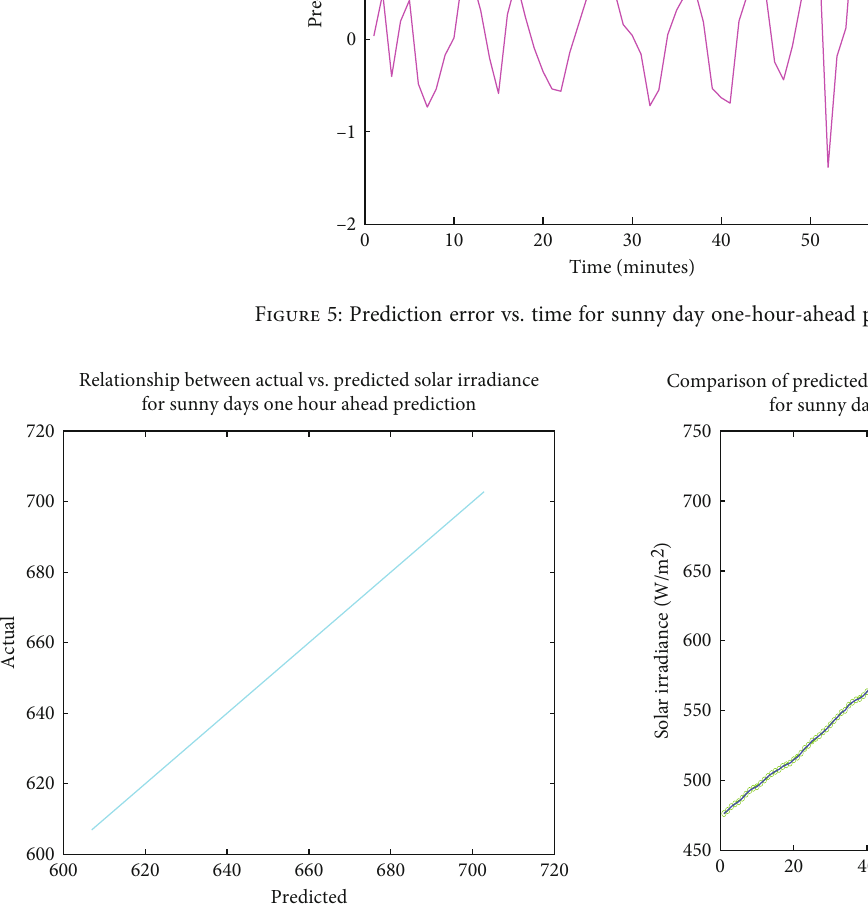
Figure 6: Relationship between actual vs. predicted solar irradiance for sunny day one-hour-ahead prediction.